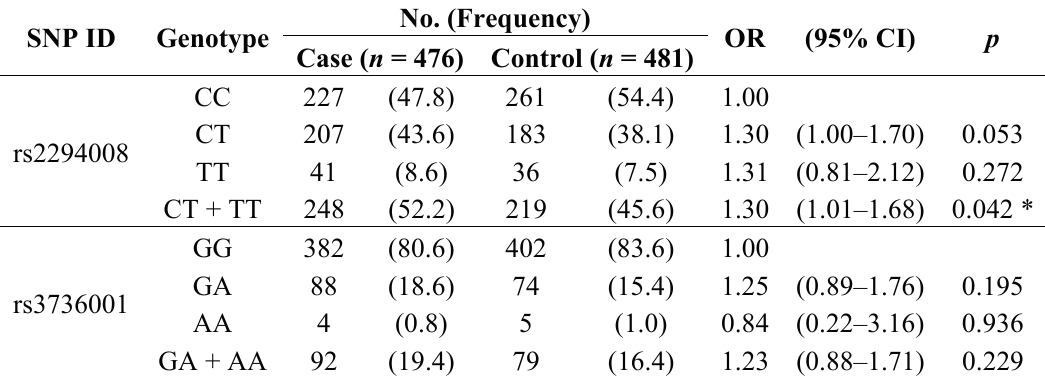
Table 3. Genotype frequency of prostate stem cell antigen ( PSCA ) variation and their association with gastric adenocarcinoma (GAC)